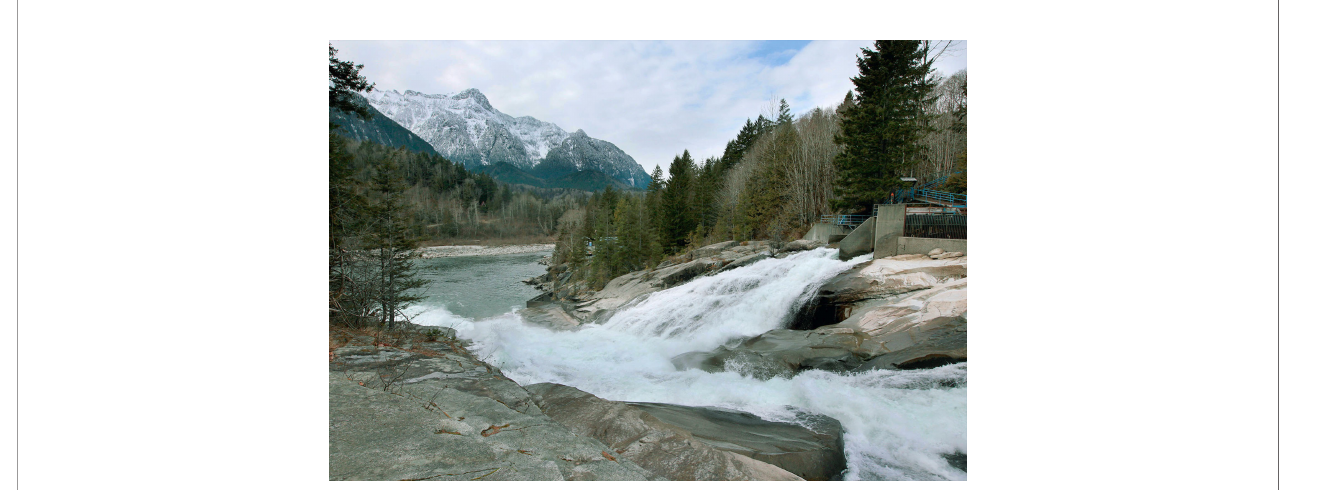
FIGURE 2 | Sunset Falls on South Fork of the Skokomish River (Source: Sanders,